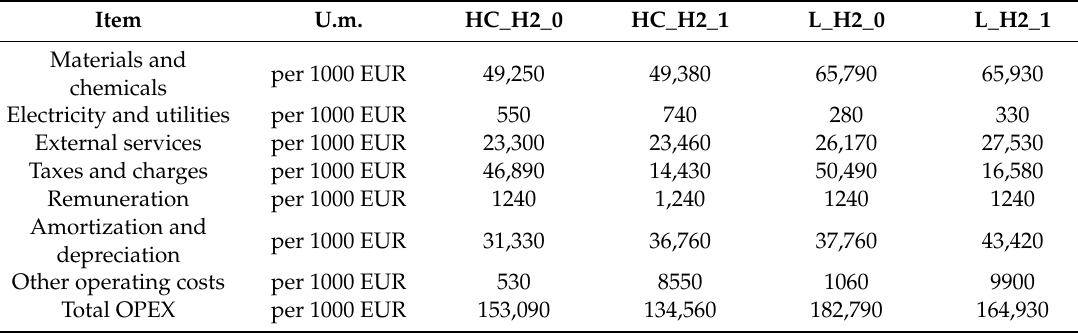
Table 6. Operating costs for analyzed technologies in the first year of